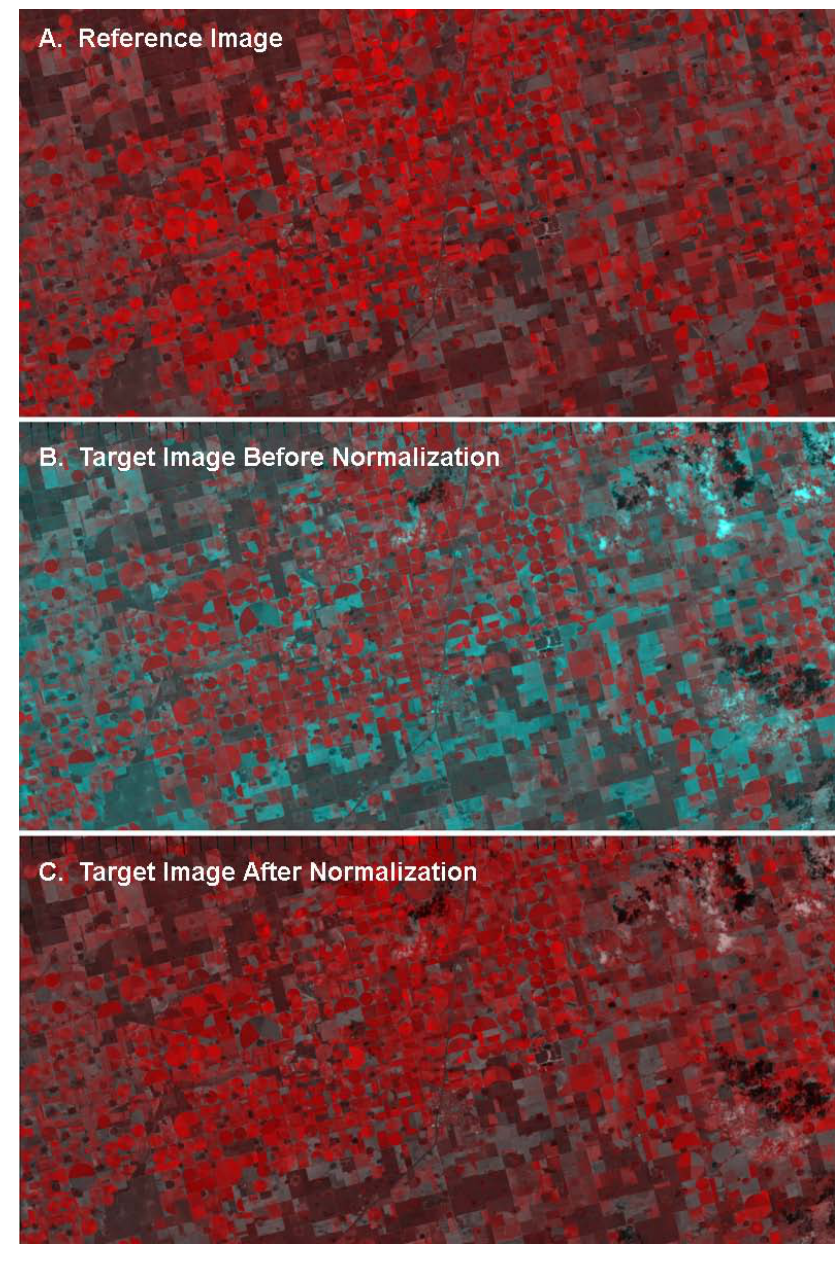
Figure 4. False-color composite representations of the image sections used in the normalization example. (A) Reference image. (B) Target image before normalization. (C) Target image after